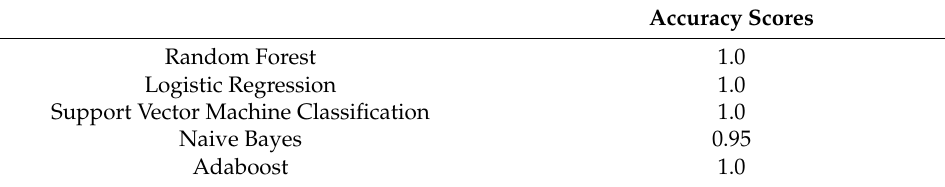
Table 6. Accuracy scores report.